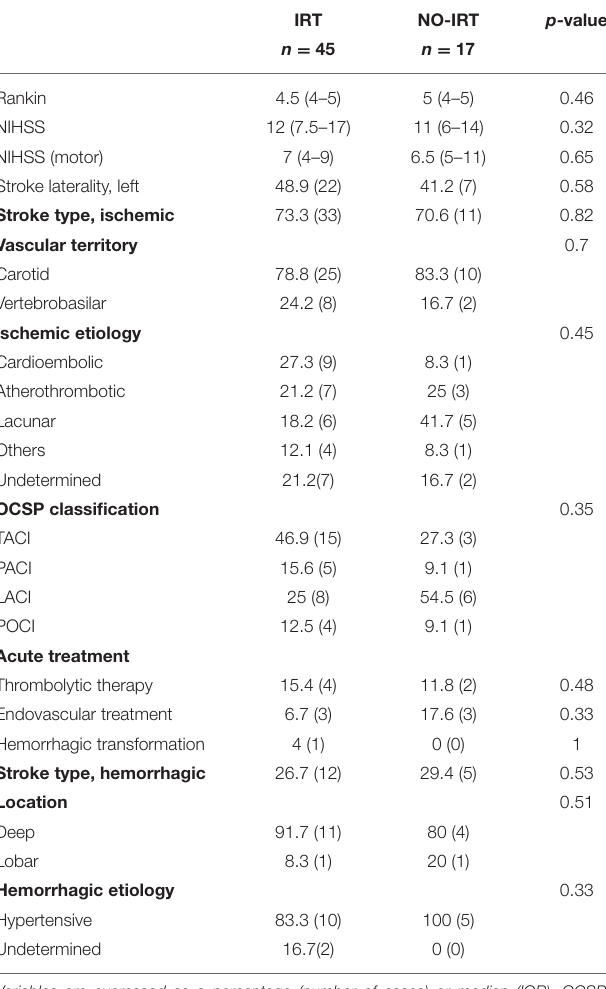
TABLE 3 | Clinical characteristics of IRT and NO IRT group on admission. TABLE 4 | Post-stroke rehabilitation characteristics at baseline visit.